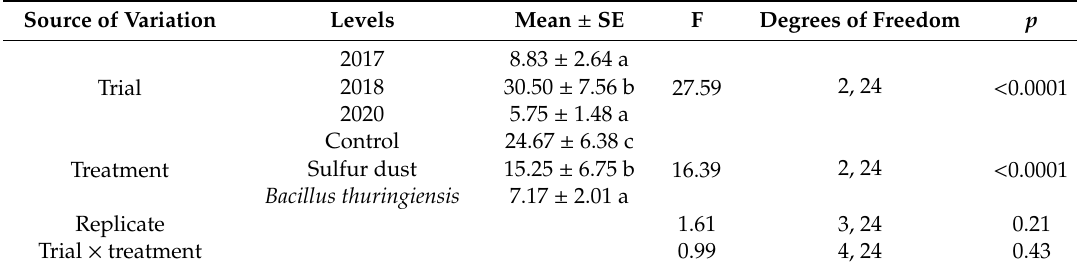
Table 1. Lobesia botrana second generation. Larval nests per 100 bunches recorded in the three field trials conducted in 2017, 2018, and 2020,